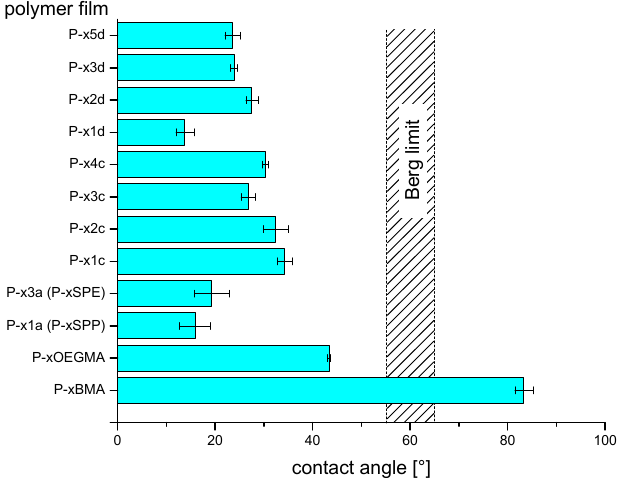
Figure 6. Water-air contact angles measured for glass supports coated with various polyzwitterions and reference polymers.